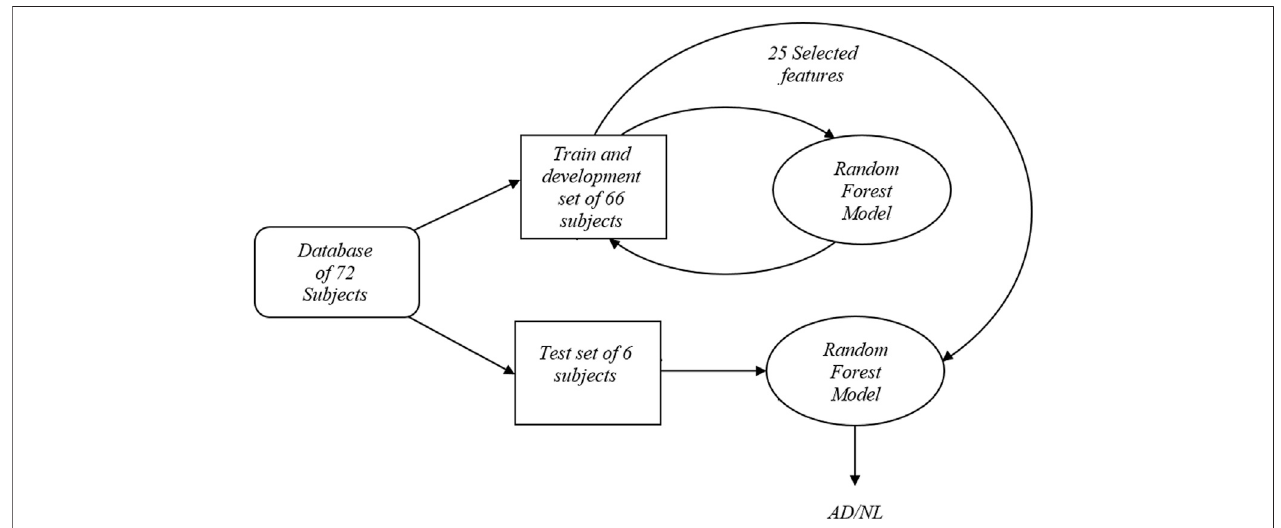
FIGURE 6 | Block diagram of random forest